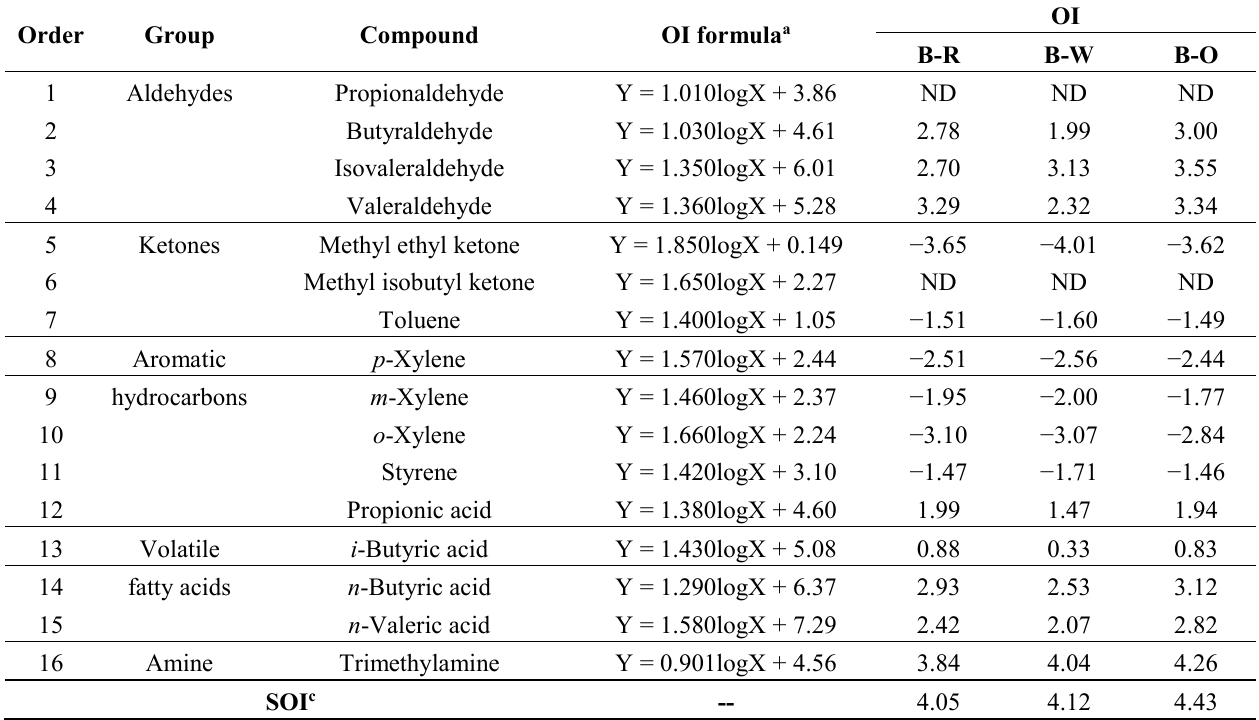
Table 6. Odor intensity (OI) formula of each compound and sum of odor intensity